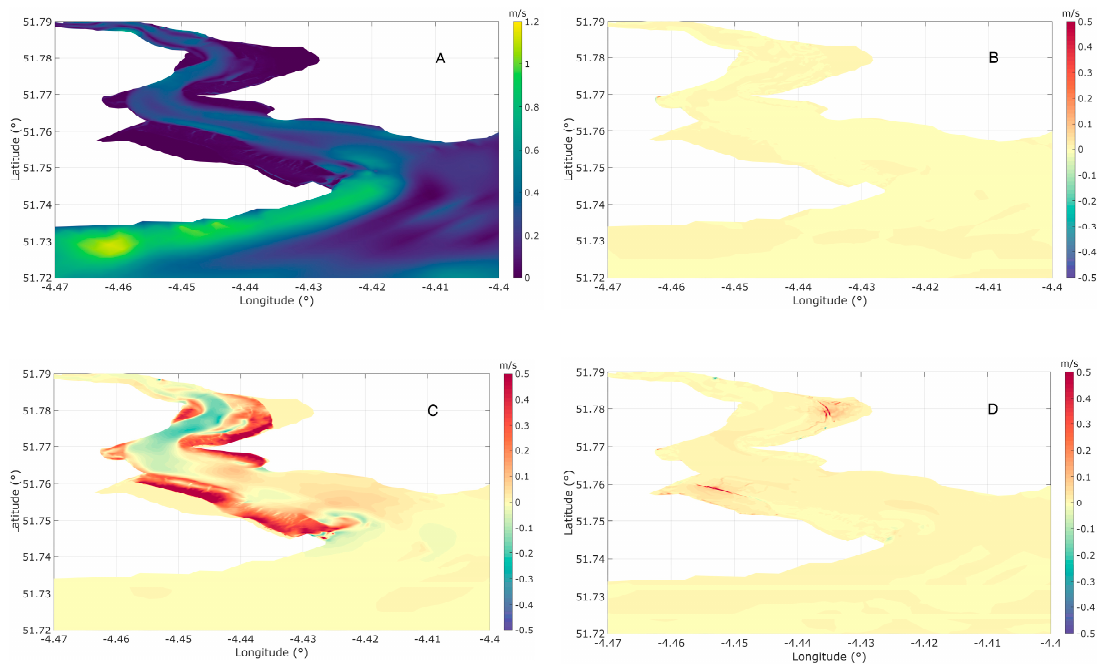
Figure 13. Comparison of peak flood current magnitude during the 1:50 year south ‐ westerly storm. ( a ) Current condition, ( b ) difference between defended and current condition, ( c ) difference between grazed and current condition, and ( d ) difference between managed realignment and current condition.